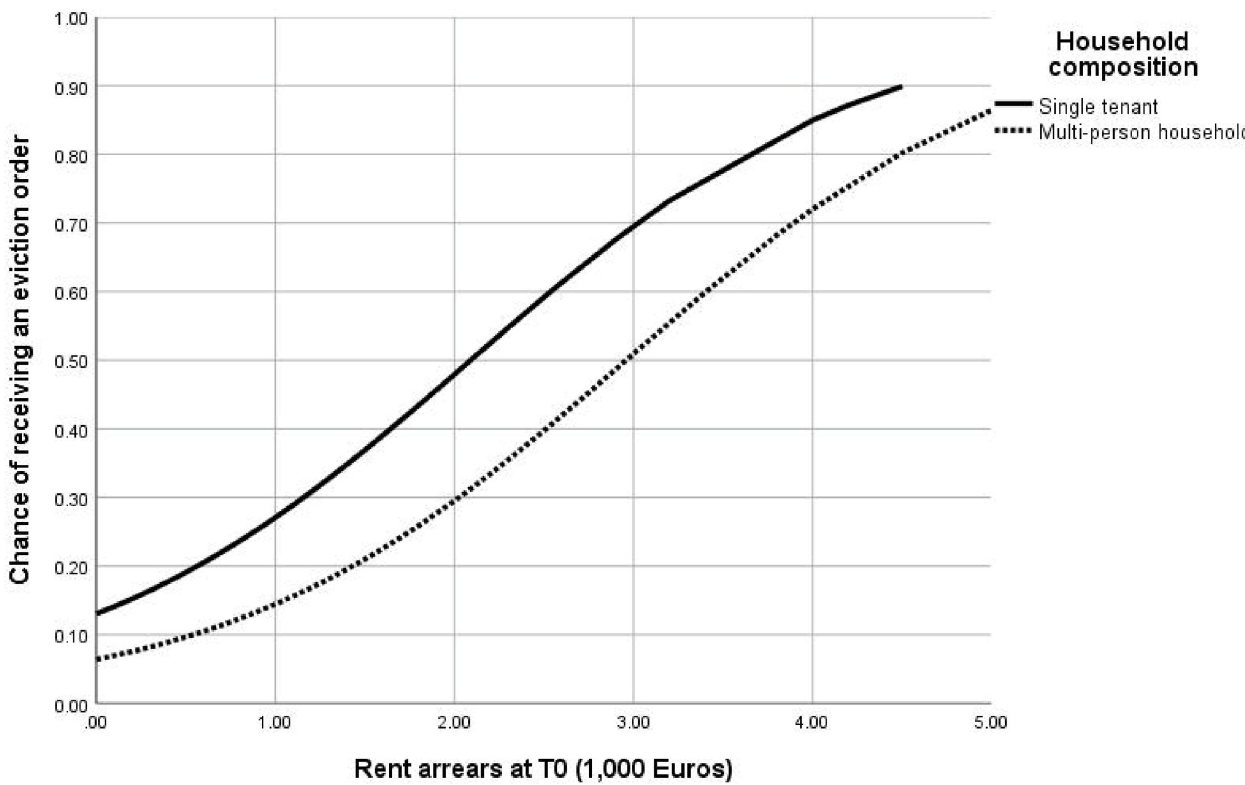
Fig 2. Probability of receiving an eviction order as a result of level of rent arrears at T0 for different household compositions, while phase in the eviction process is at average level (N = 304).